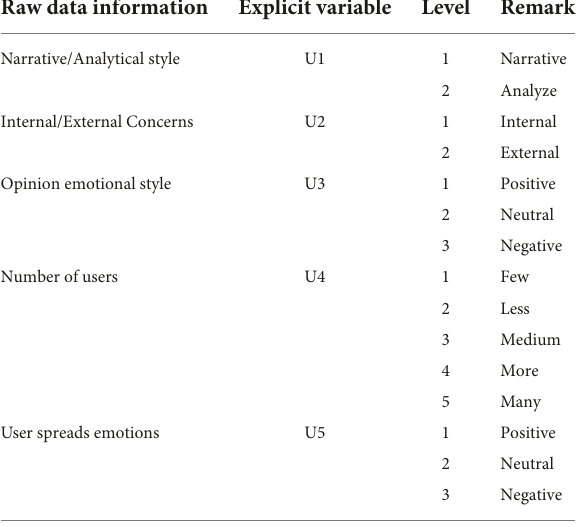
TABLE 2 Explicit variables are treated at different